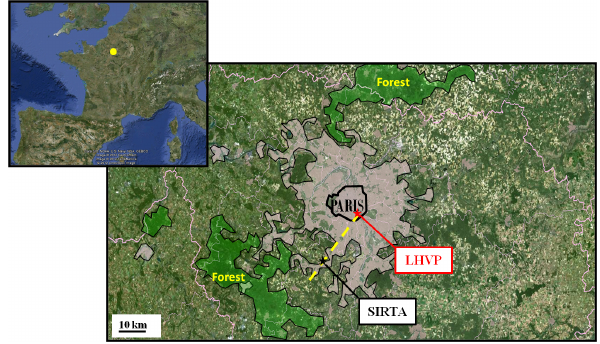
Figure 1. MEGAPOLI sampling sites (source: Google